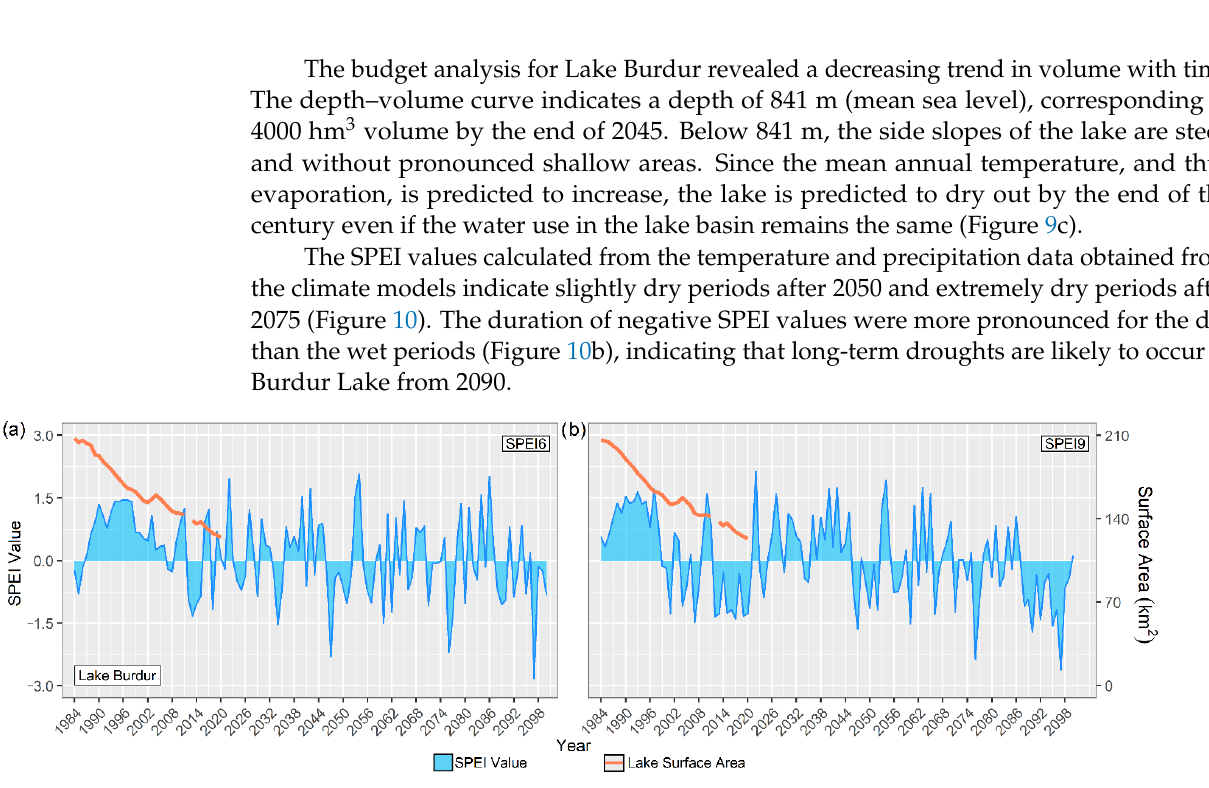
Figure 10. SPEI prediction for Lake Burdur for wet ( a ) and dry ( b ) periods based on SPEI-6 and SPEI-9, respectively.